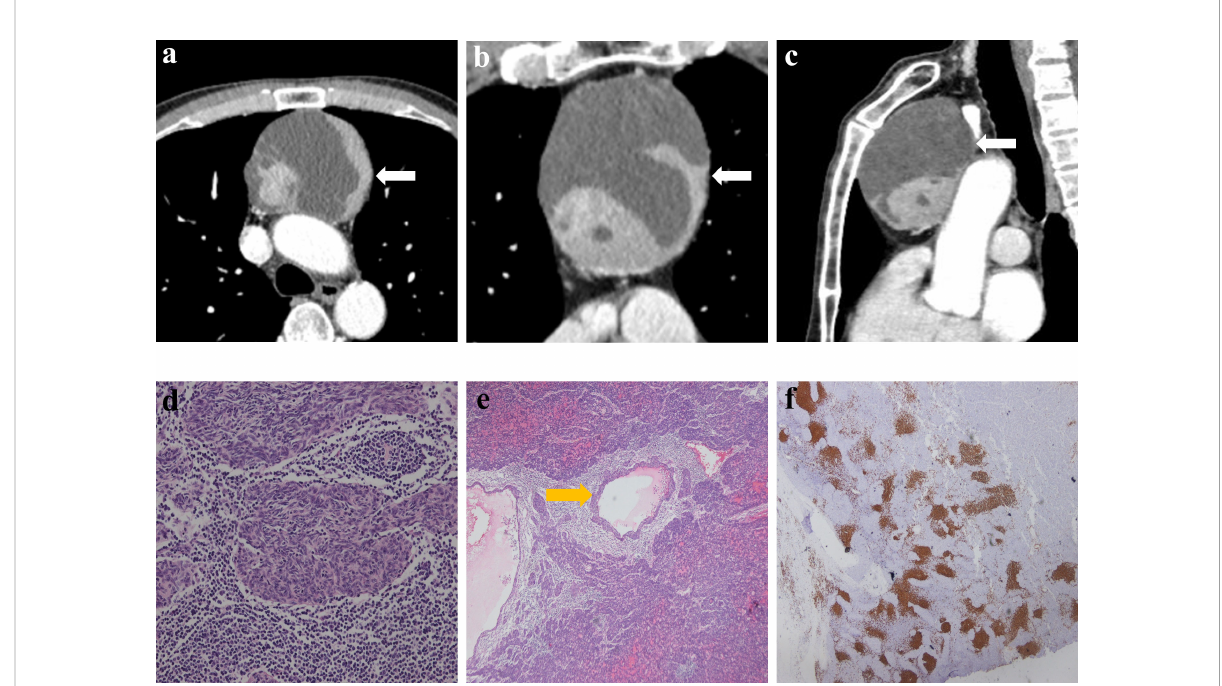
FIGURE 3 Imaging and histologic fi ndings in a 63-year-old man with primary mediastinal MTWLS (case 3). (A) Axial, (B) coronal and (C) sagittal chest CT images with contrast enhancement reveal a 7.3×7.0×9.0-cm multiple cystic region and a round or oval middle anterior mediastinal mass (white arrow) adjacent to the mediastinum pleura and large blood vessels. The measurable solid components showed signi fi cant enhancement. (D) Hematoxylin-eosin (H-E) – stained section of the mass reveals spindle cells forming multiple micronodules separated by abundant interstitial lymphocytes. (E) Cyst walls (yellow arrow) were covered with nodular tumor. (F) Lymphocytes had diffusely strong positive immunostaining for CD20 (= B cells), and the epithelial cell nests were negative for